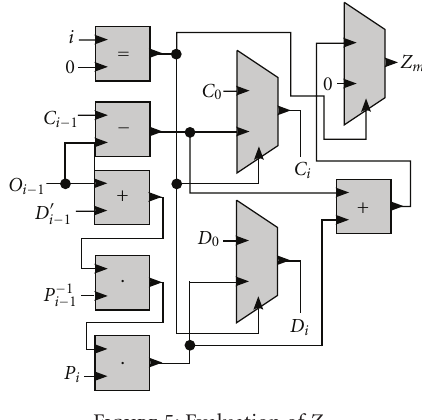
Figure 5: Evaluation of Z m .